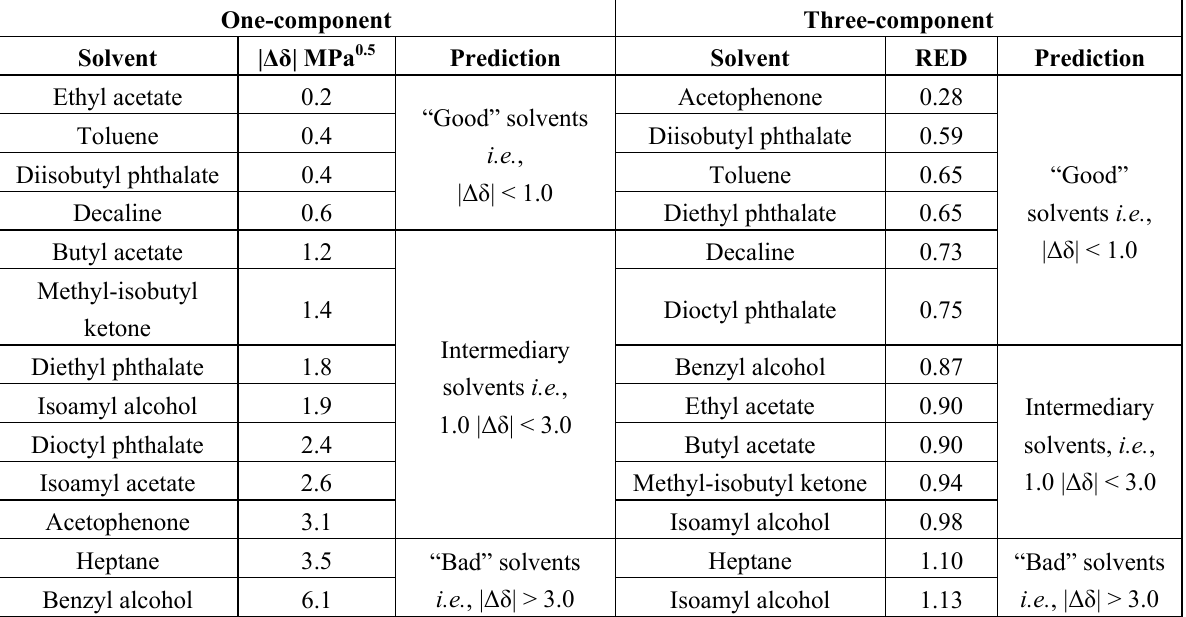
Table 3. Prediction of porogenic solvents in terms of one- and three-component SP criteria; relative energy difference (RED) is calculated using Equation 3. (Data obtained from [34]).